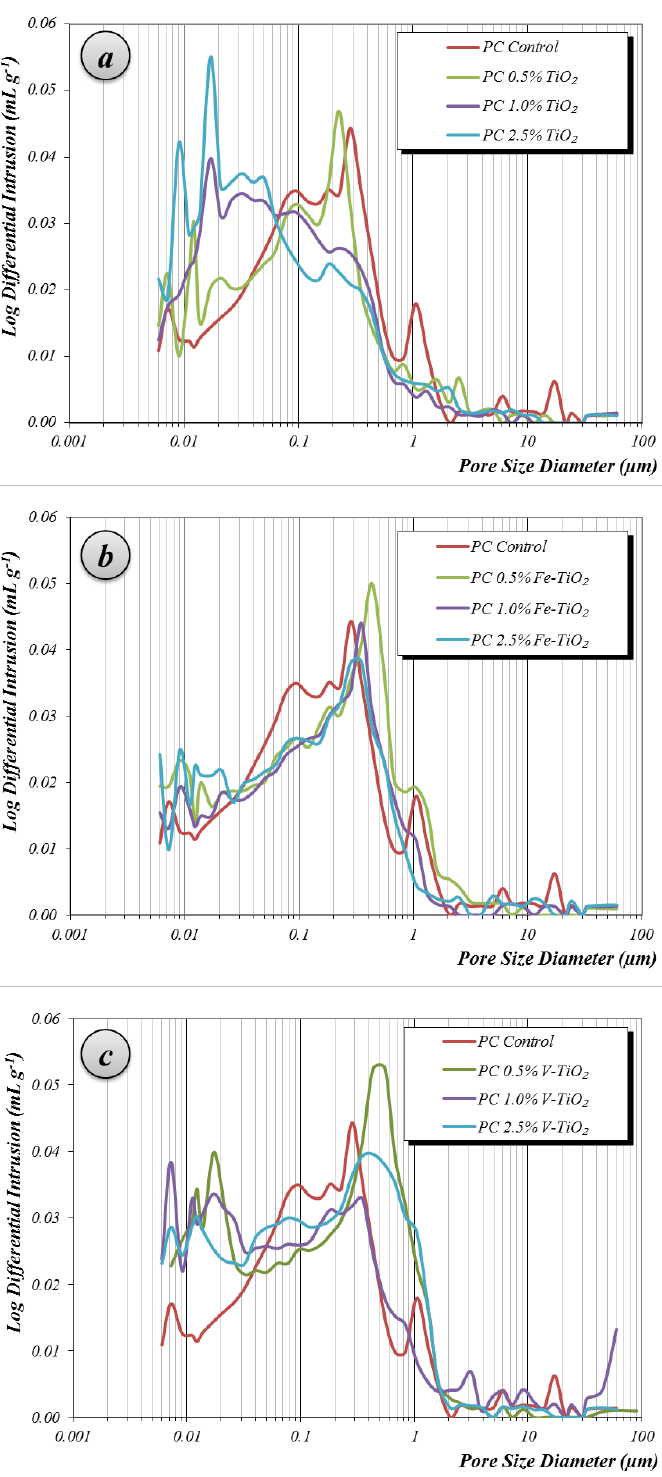
Figure 6. Pore size distribution results of PC samples after 28 curing days for: ( a ) TiO 2 ; ( b ) Fe-TiO 2 ; ( c ) V-TiO 2 . ( c ) V-TiO 2